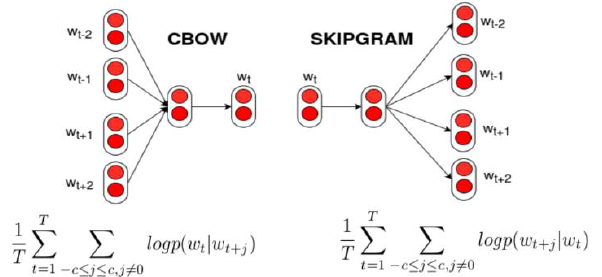
Figure 2. Continuous bag-of-words (CBOW) and Skipgram architecture. (https: // commons.wikimedia. org / author: